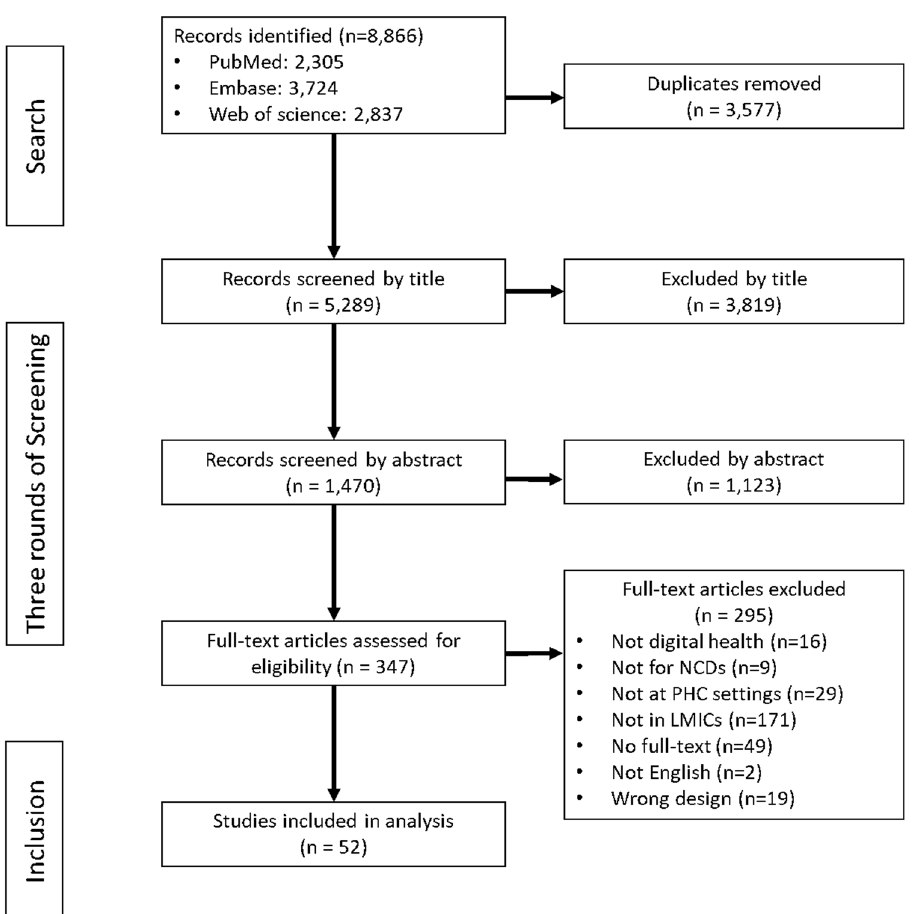
Fig. 1 Flowchart for study search and screening. The initial results were 8866 items. After duplicate removal and screening by title, abstract, and full-text, a total of 52 papers were included for fi nal